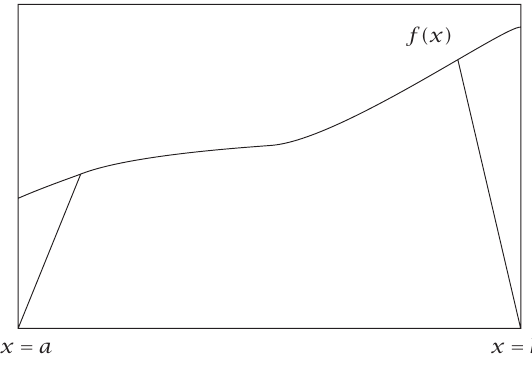
Figure 2.3 . Third approximation to the area under f(x)